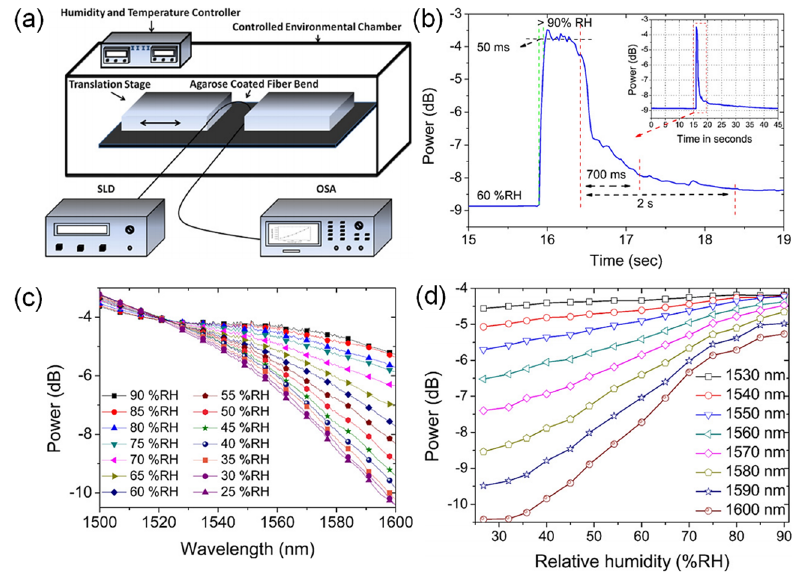
Figure 17. Point sensor. ( a ) Experimental setup. ( b ) Temporal response. ( c ) Relationship between wavelength and power for different RHs. ( d ) Relationship between power and RH for different wavelengths. Reprinted with permission from [72] © Elsevier .